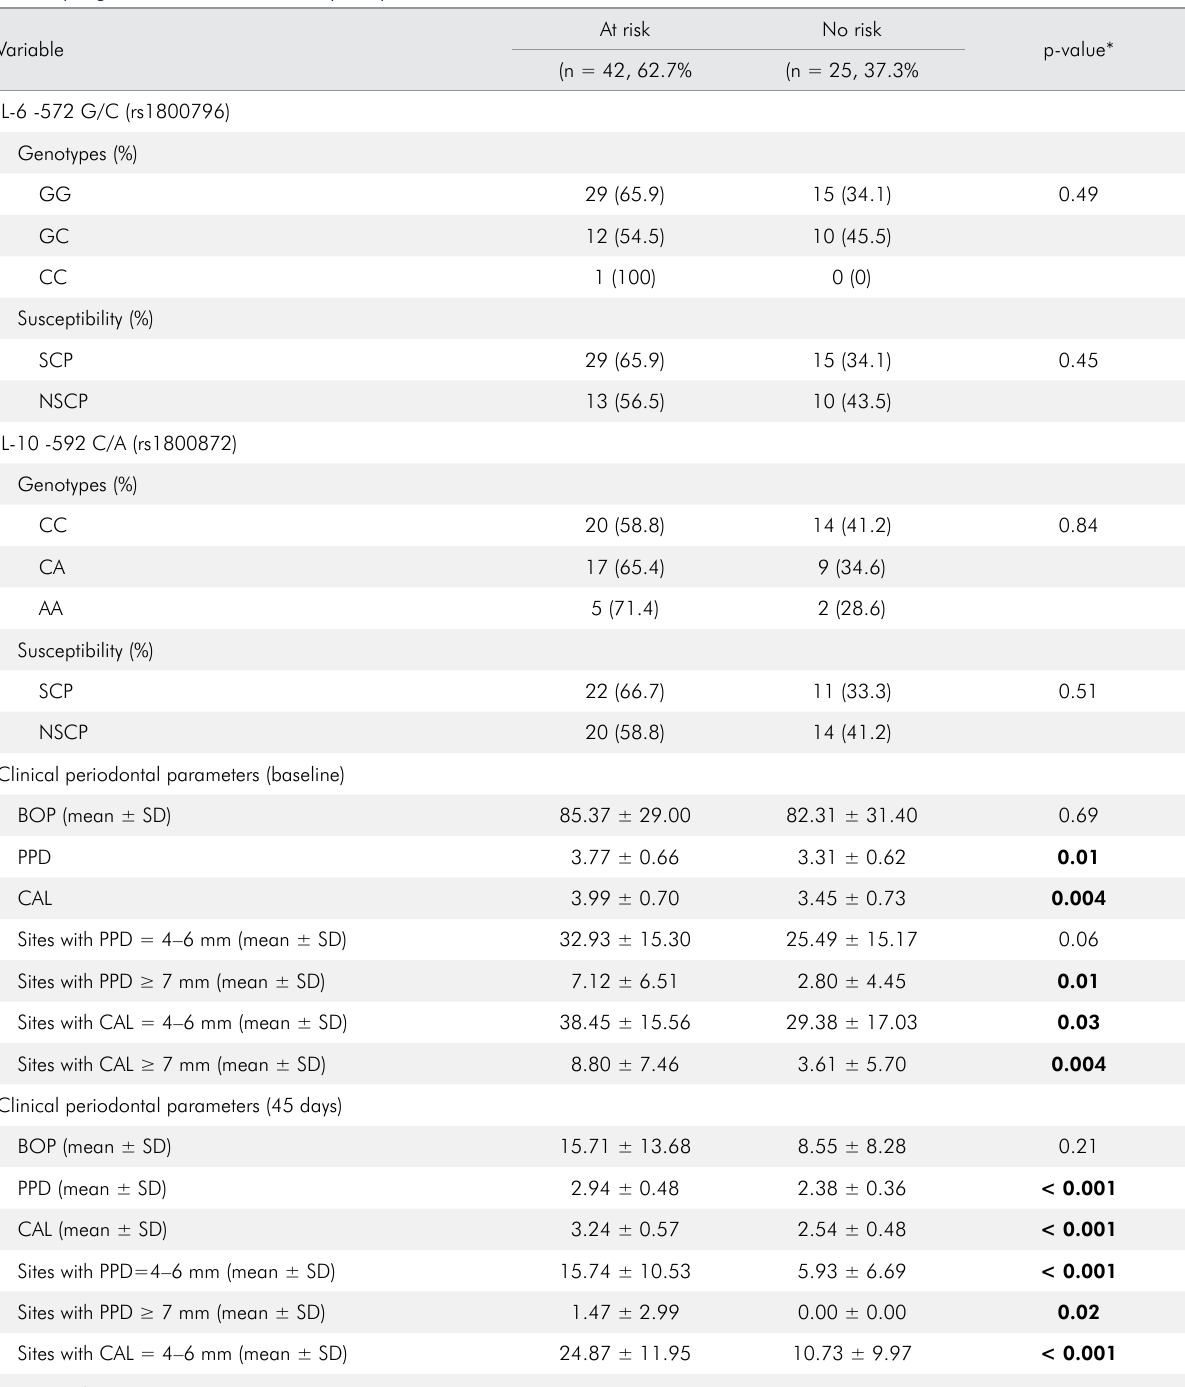
Table 2. Distribution of IL-6 -572 G/C (rs1800796) and IL-10 -592 C/A (rs1800872) genotypes as well as clinical periodontal parameters at baseline and the 45 th day following periodontal treatment among individuals at risk or not at risk of periodontal disease progression as determined by the presence of at least one site with residual PPD ≥ 6 mm. At risk No risk Variable p-value* (n = 42, 62.7% (n = 25,